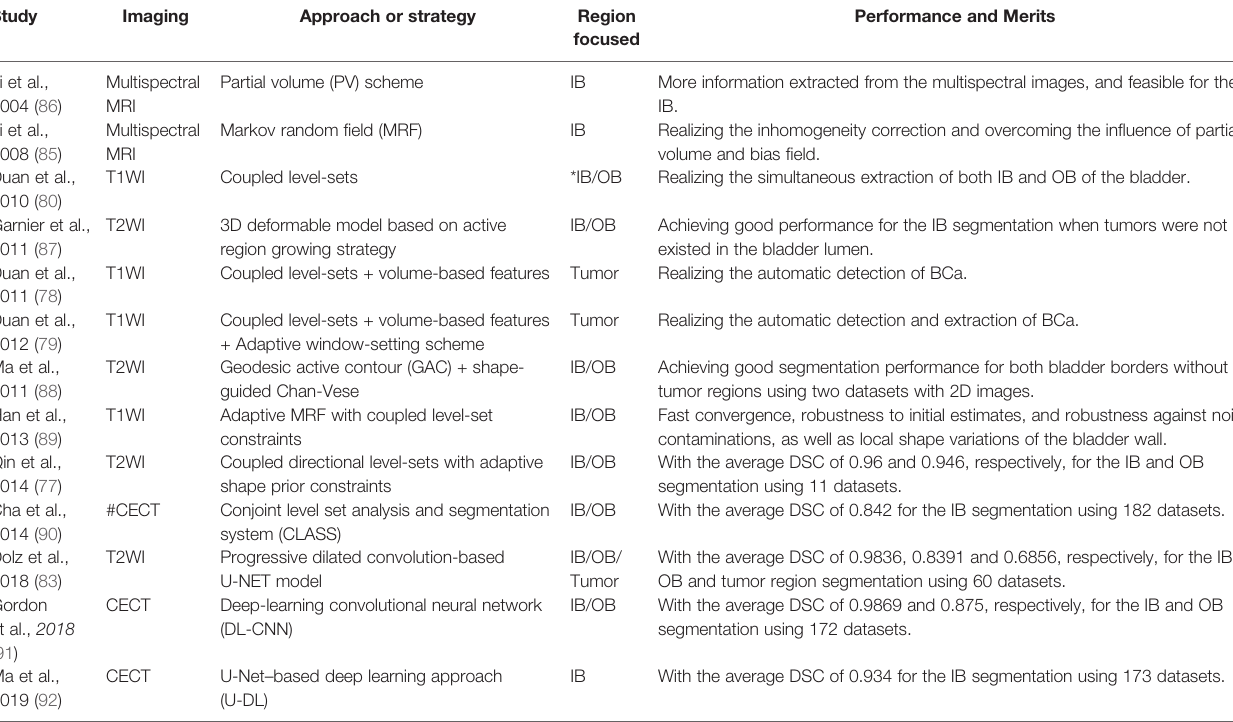
TABLE 1 | Related studies and methodology of CT-/MRI-based bladder image segmentation during the past 20 years. Study